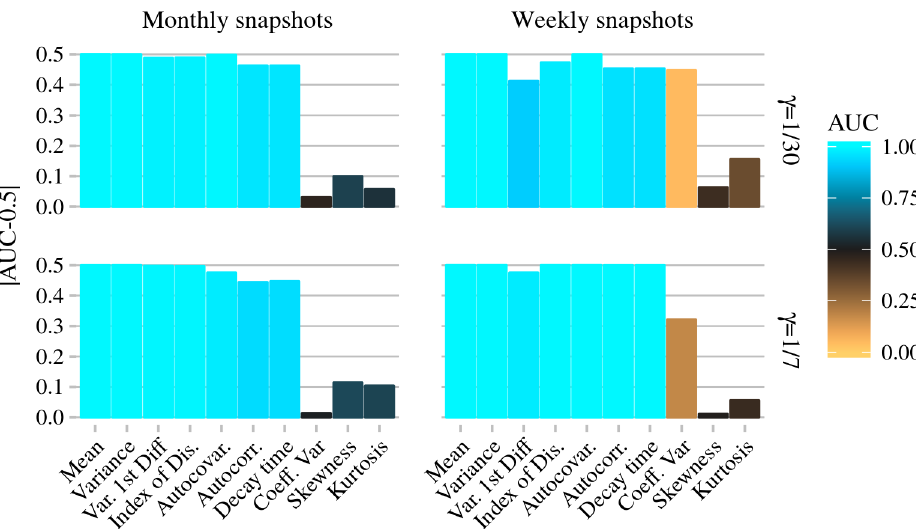
Fig 4. Performance of EWS calculated from weekly and monthly snapshots of the infectious population. AUC values further from 0.5 imply better performance. To investigate performance when the aggregation period is less than, equal to, and greater than the infectious period, results are shown for 1/ γ = 1 week and 1 month. Simulations were performed using a stochastic non-fatal SIR model with birth and death. In a fully susceptible population, on average 1 susceptible individual per week acquires the infection from external sources. Individuals have a mean lifespan of 70 years. The average population size N = 10 6 individuals. In simulations of the emerging scenario, R 0 increases linearly from 0 to 1 over 20 years, in simulations of the stationary scenario R 0 = 0. AUC values calculated using 1000 replicates of both models, see Methods.